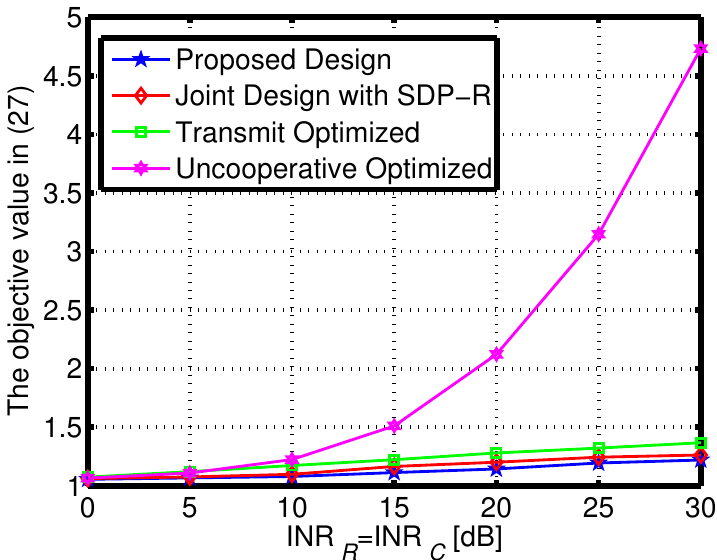
Figure 5. The objective value under different INR R = INR C of mutual interference.